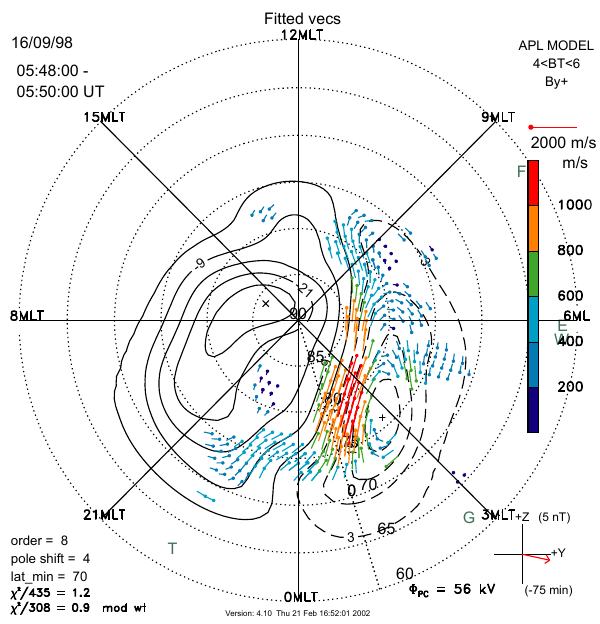
Fig. Fig. 8. Solution for the global convection pattern calculated with the map-potential technique using l-o-s velocity data from all 6 of the Northern Hemisphere SuperDARN radars, 05:48 to 05:50UT. The electrostatic potential was expanded to an order of L = 8 (Ruo- honiemi and Baker, 1998), and the flow was assumed to be centered 4 ◦ from the pole. The low-latitude limit of the convection zone was assumed to be 70 ◦